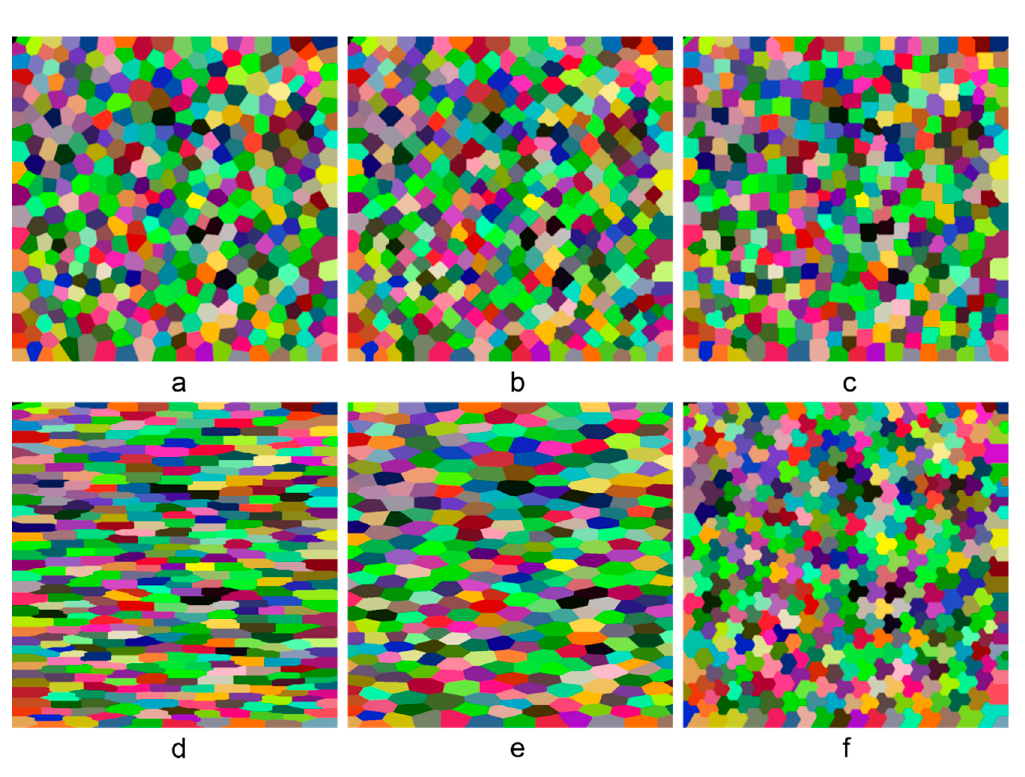
Figure 3. Voronoi diagrams generated with different distance function: ( a ) L 2 -metric distance; ( b ) Manhattan distance; ( c ) Chebyshev distance; ( d ) Chebyshev distance with axial scale; ( e ) L 2 -metric